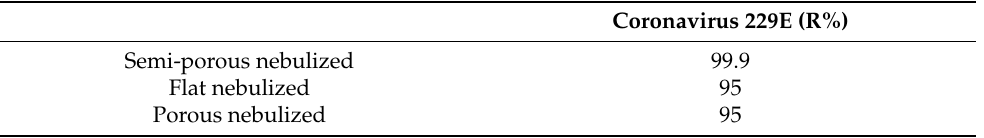
Figure 6. Virucidal effect of hypochlorous solution against Coronavirus 229E ( A panel) and Adenovirus V ( B panel) 1 × 10 7 pfu/mL. HCoV-229E and Adenovirus V were incubated in the different surfaces and subjected to nebulization with a concentration of 300 ppm of HOCl. The nebulization time was set to 3 min and the exposure times 10 min. Data represent the percentage of viral reduction. Values were obtained by comparing the results with the virus control and represent the mean of 3 independent experiments. * p < 0.05. Table 3. Percentage values of plaque reduction after nebulization with hypochlorous solution at 300 ppm on different surfaces contaminated with Coronavirus 229E. All the data reported are the average of three independent experiments conducted (each experiment) in triplicate.